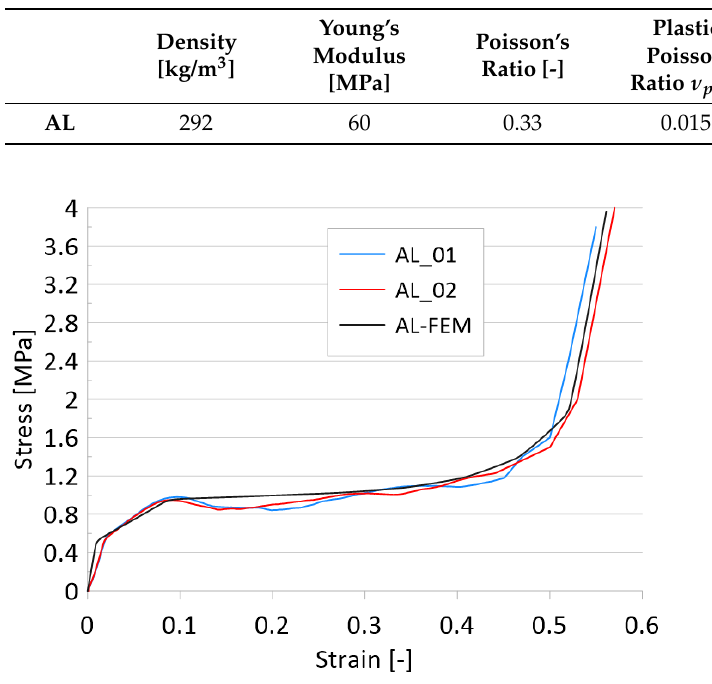
Figure 3. Stress-strain curve of the foamed material.